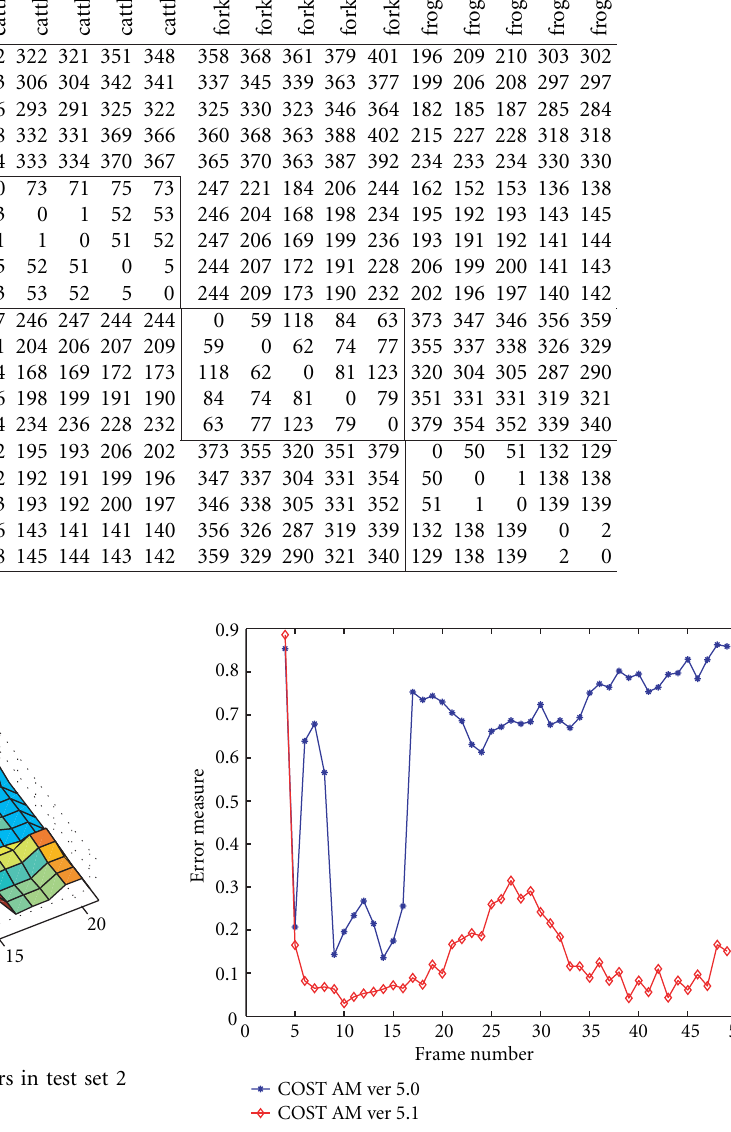
Figure 10: The segmentation performance scores for frames 4–49 of the sequence “Erik,” for COST AM versions 5.0 and 5.1.